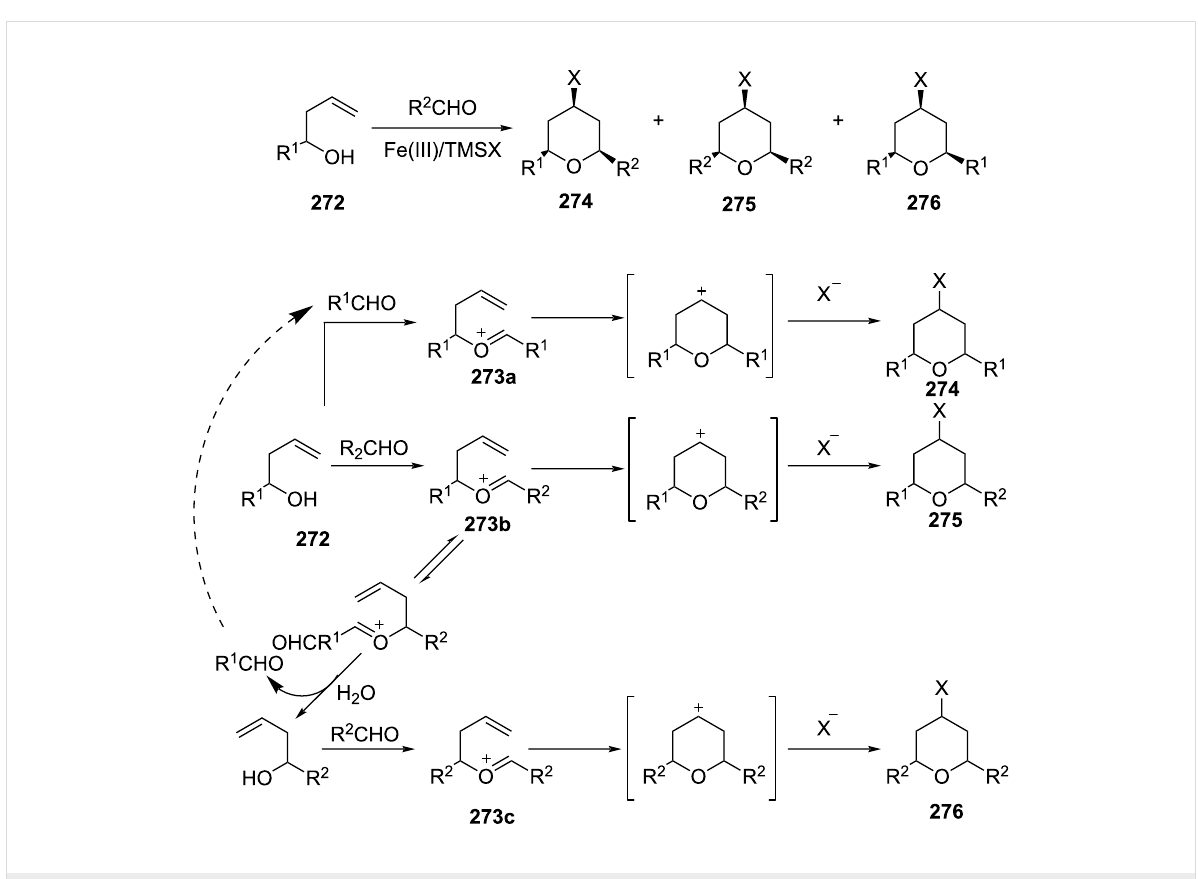
Scheme 65: Selectivity profile of the Prins cyclization under participation of an iron ligand.